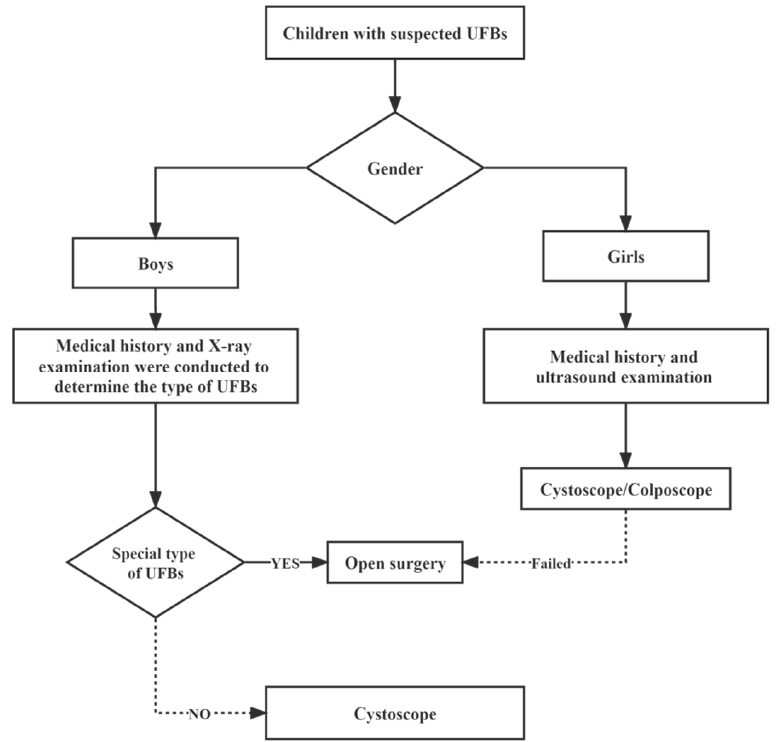
Figure 1. Management of children with UFBs.